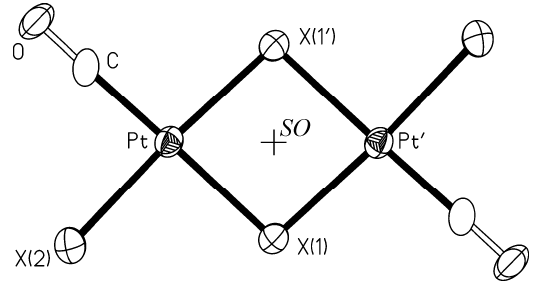
Figure 2. The molecular structure of trans -Pt ellipsoids are at 30% probability. SO is the symmetry operator relating the two halves of the molecule: 1 for X = Cl and I( α ) and 2 for X = Br and I( β